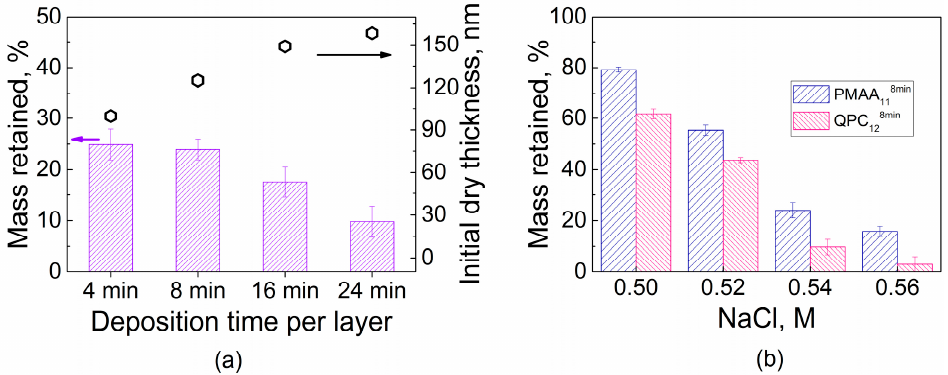
Figure 2. ( a ) Total film thicknesses and stability of PMAA 11 films assembled using different deposition times per layer upon post assembly overnight exposure to 0.54 M NaCl; ( b ) stability of PMAA